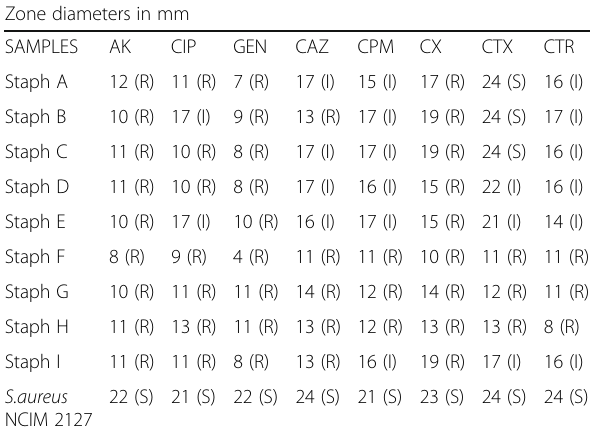
Table 1 Antibiotic susceptibility profile of clinical isolates and S.aureus NCIM 2127 (zone diameters achieved were compared with the CLSI standards) Zone diameters in